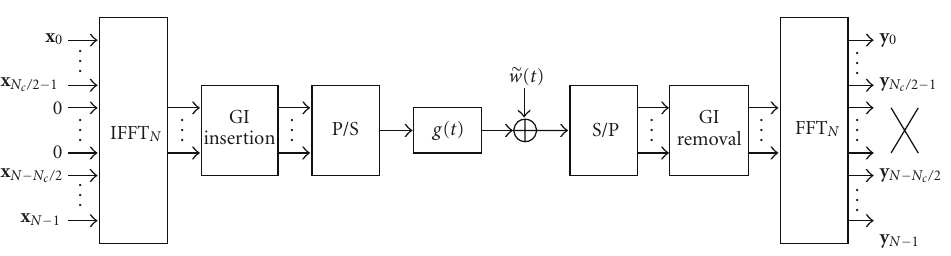
Figure 2: Block diagram of OFDM